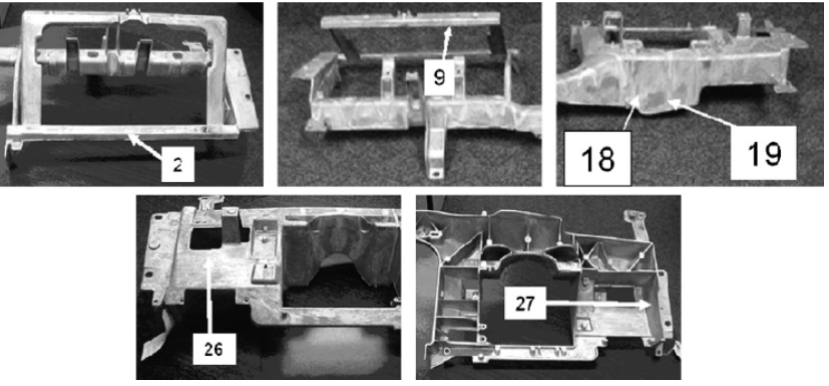
Figure 2. Identification of the investigated regions [1].